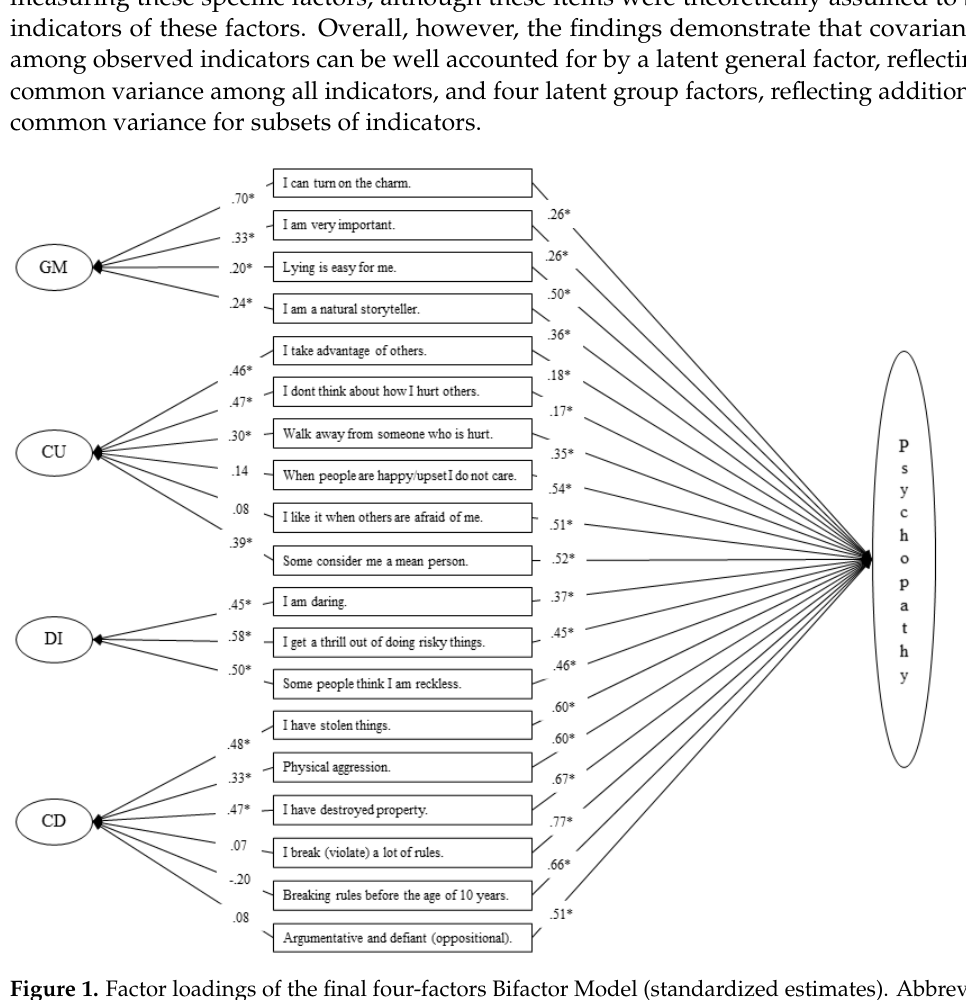
Figure 1. Factor loadings of the final four-factors Bifactor Model (standardized estimates). Abbrevi- ations: GM, Grandiose–Manipulative; CU, Callous–Unemotional; DI, Daring–Impulsive; CD, Con- duct Disorder. * p <